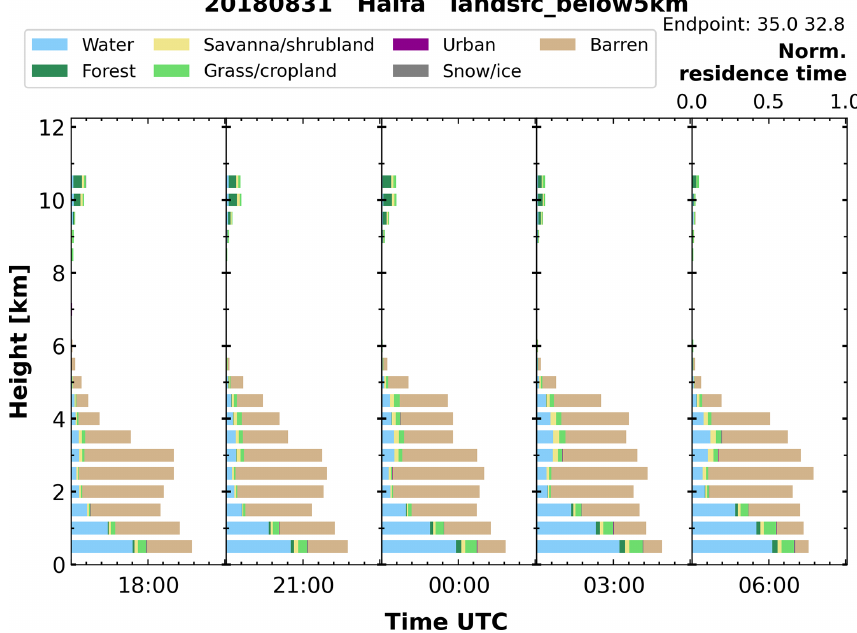
Figure 5. Air mass source estimate on 30 and 31 August 2018 for land cover classification based on FLEXPART particle positions. For each 3h time step, the normalized residence time of the air mass over a particular land cover class is shown. The vertical step is 500m and the reception height is